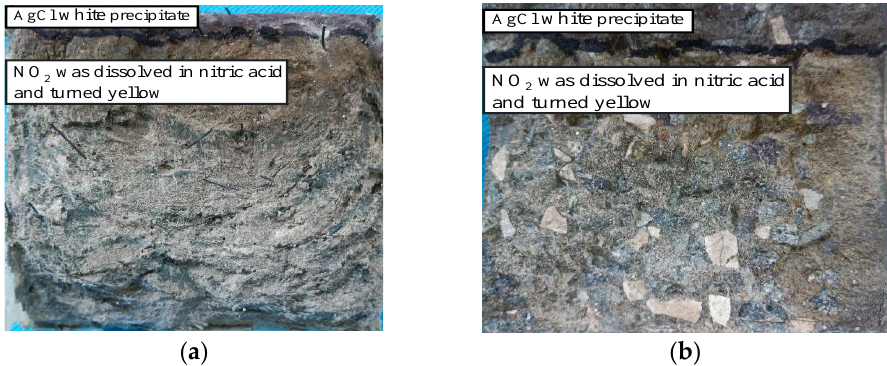
Figure 12. Erosive Chloride Ion image showing depth of specimen after 20 cycles of dry-wet corrosion. ( a ) SMA-ECC ( b ) MC.